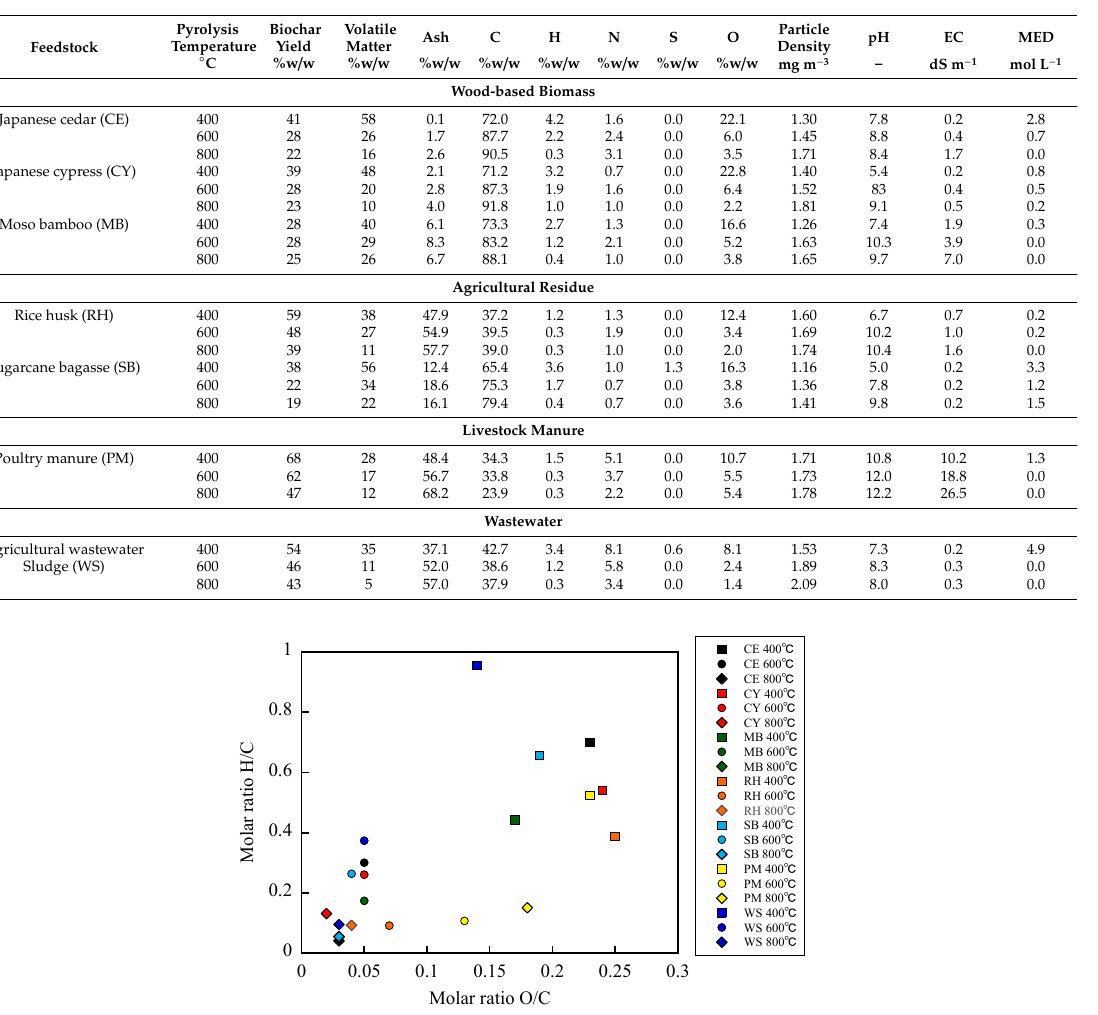
Table 1. Physicochemical properties of biochar samples.